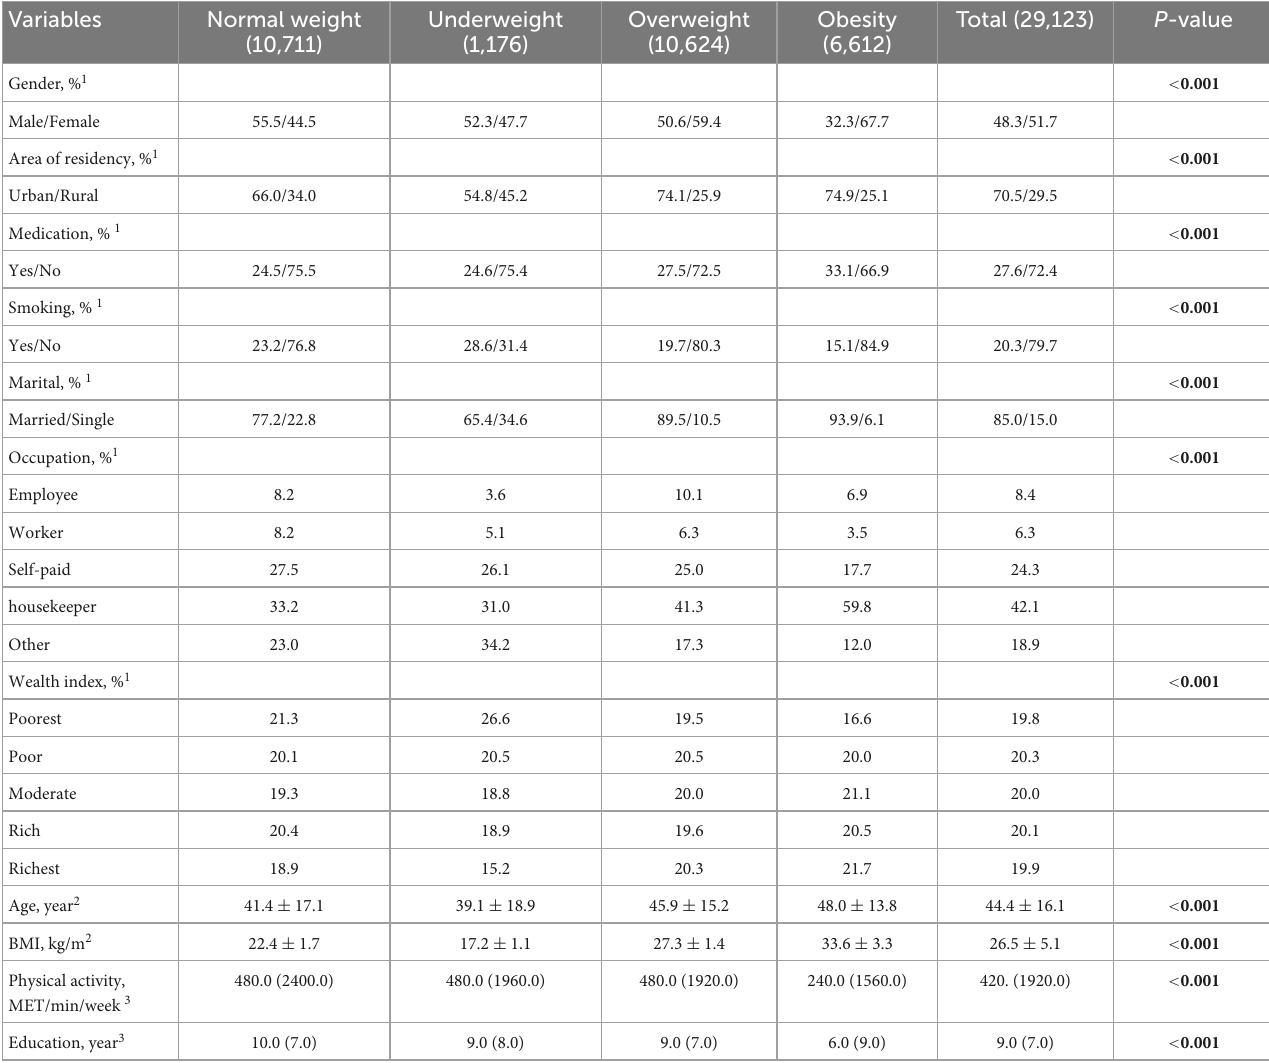
BMI,bodymassindex;MET,metabolicoftask.Valuesarereportedmean ± SDormedian(IQR)andpercentage. 1 Usingchi-squaretestforcategoricalvariables. 2 Usingone-wayANOVAfornormal continuous variables. 3 Using Kruskal–Wallis for abnormal continuous variables. Normal weight: BMI 18.5–24.9 kg/m 2 , underweight: BMI < 18.5 kg/m 2 , overweight: BMI 25–29.9, and obesity: BMI ≥ 30kg/m 2